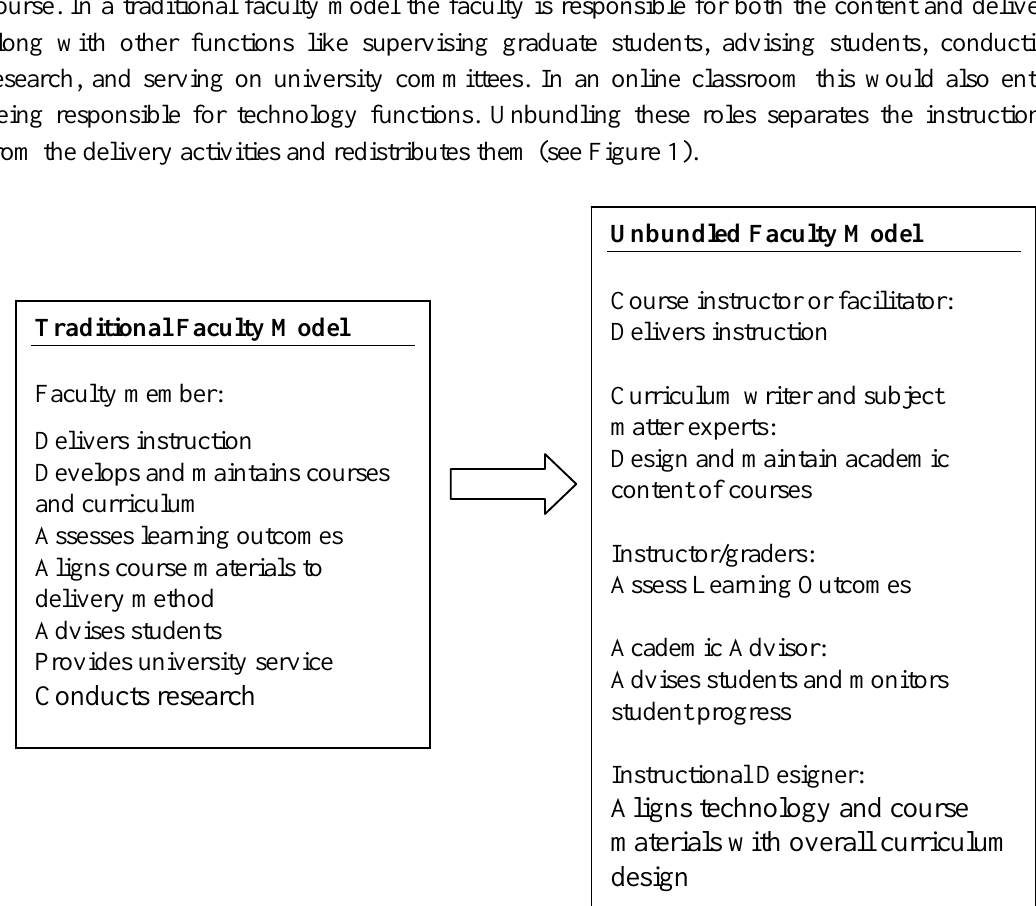
Figure 1 . This figure illustrates the unbundling of a traditional faculty